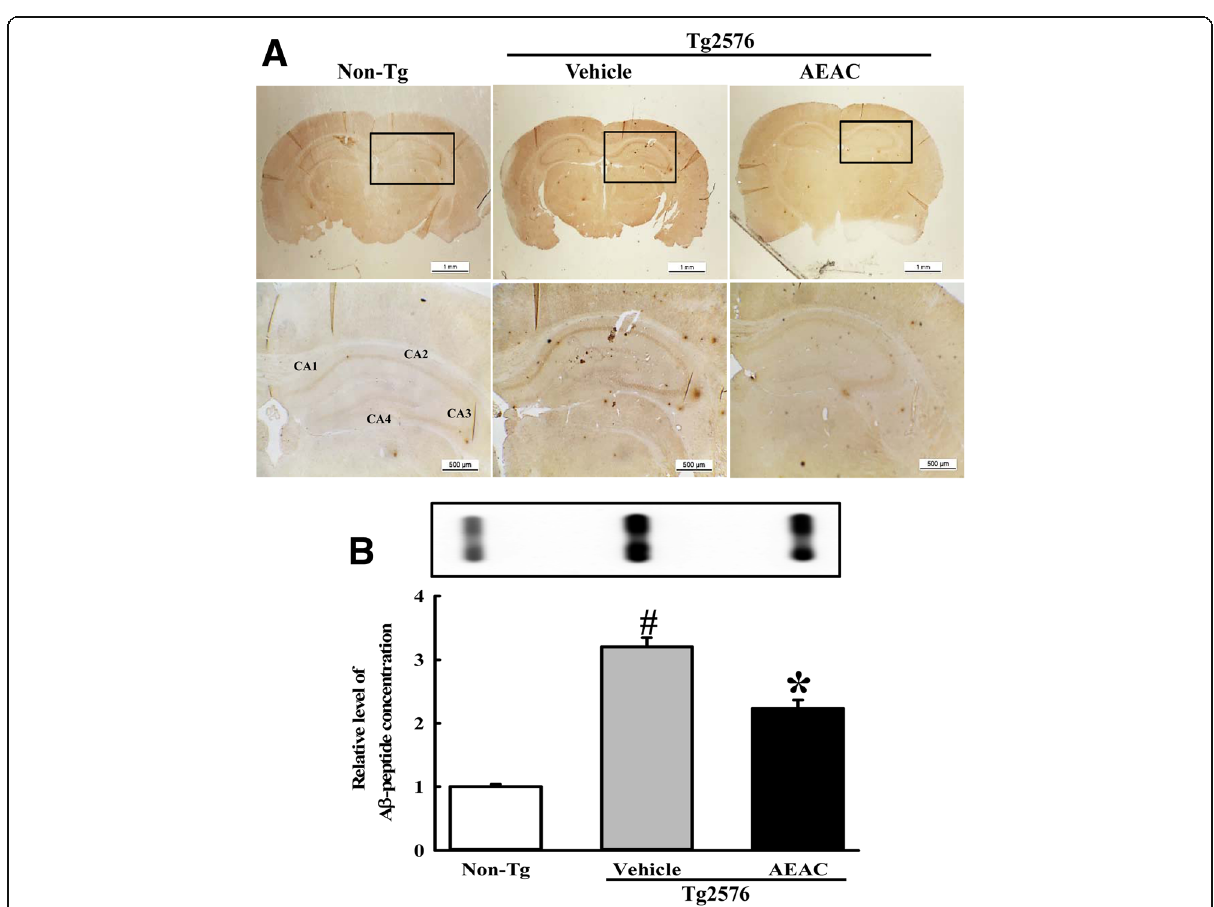
Fig. 6 Deposition and concentration of A β -42 peptides. a Deposition of A β -42 peptides in brains of Tg2576 mice was detected by immunostaining using specific antibody. Whole brains including the hippocampus and cortex were observed at 10× (upper column), while detailed histological features of several regions of the hippocampus are shown in three rectangles at 400× (lower column). b Concentration of soluble A β -42 peptides in brains of Tg2576 mice was detected by dot blot assay. Data are reported as the means ± SD. # , P < 0.05 compared to the Non-Tg group. *, p < 0.05 compared to the Vehicle treated Tg2576